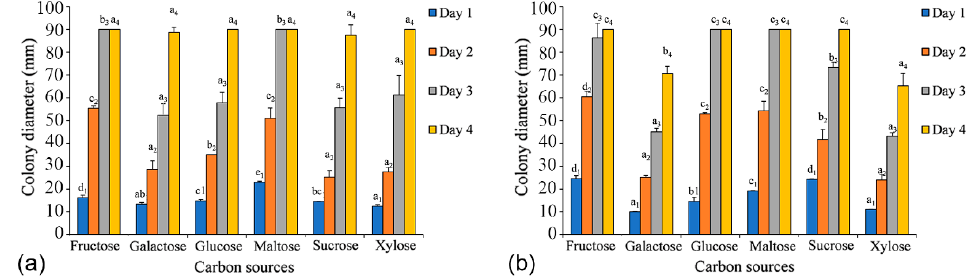
Figure 8. Effects of carbon sources on the growth of Cytospora species. ( a ) Cytospora alba (CFCC 55462). ( b ) Cytospora paracinnamomea (CFCC 55453). A p -value < 0.05 was considered significant. Graphs with SE-bars showed the difference in mycelium growth under different conditions.